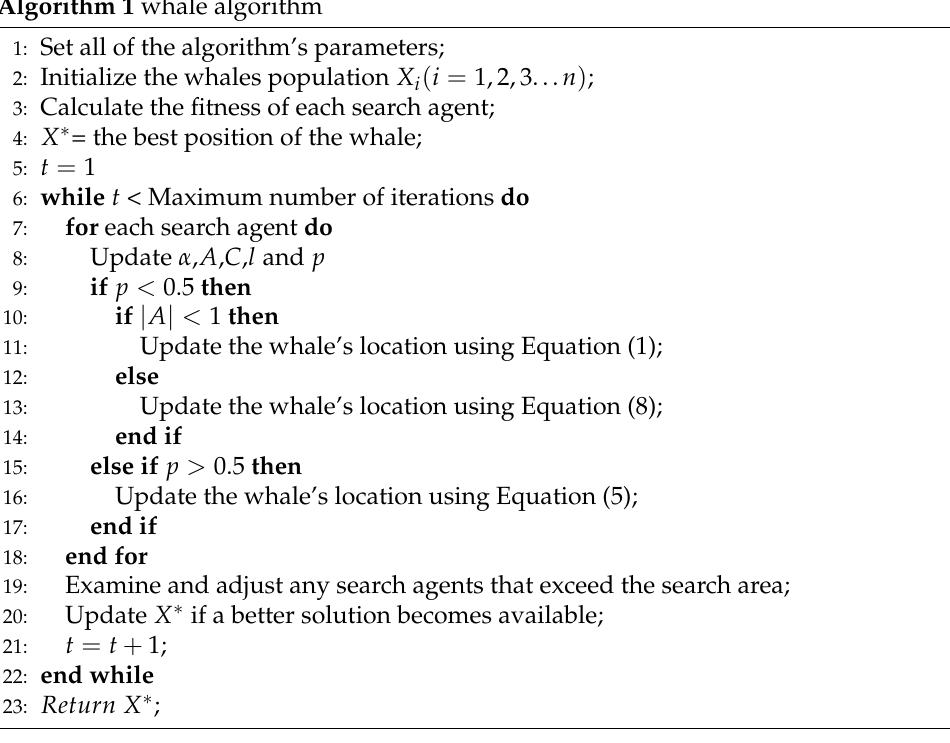
Algorithm 1 whale